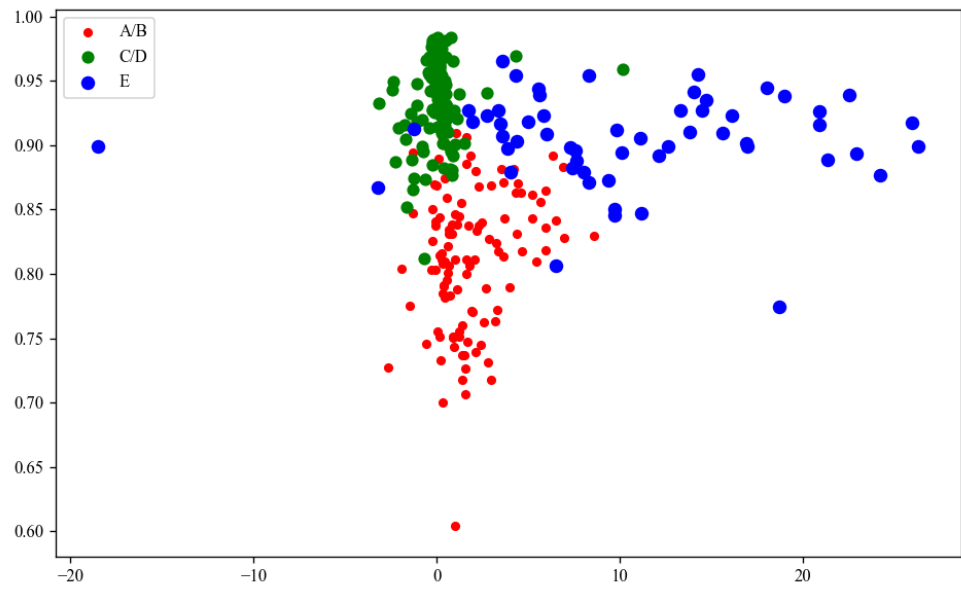
Figure 5. The distribution of extracted features in two dimensions.